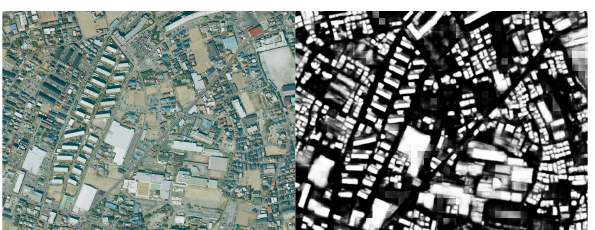
Figure 5. Predicted map patch in Saitama District year 2007 after undergone semantic segmentation by CNN